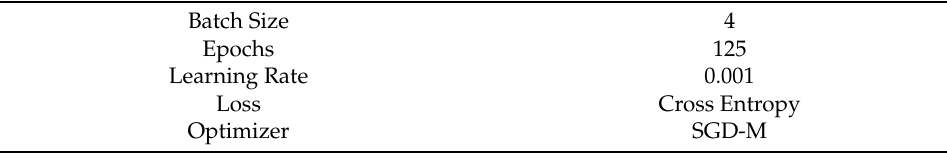
Table 3. Hyperparameters.